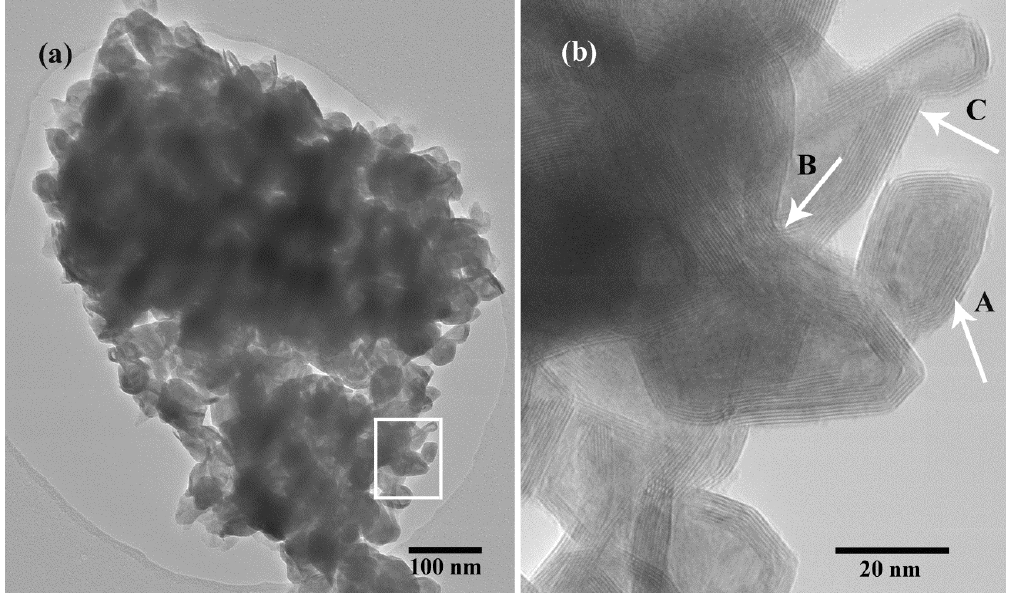
synthesised using the rotary process ( a – d ; b is a 2